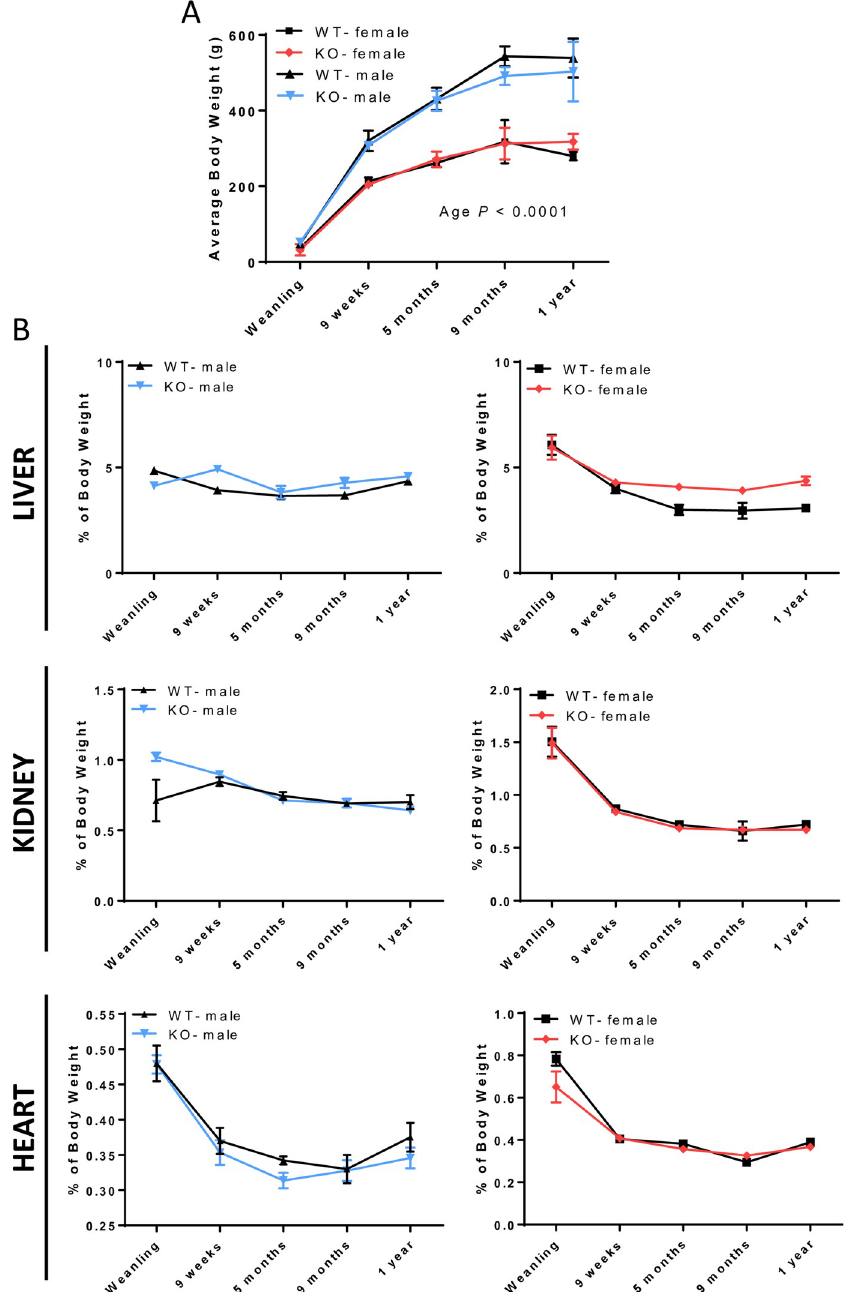
Fig 3. Hamp ablation did not alter growth rates or organ weights in male and female rats. Average body weights (recorded on the day of sacrifice) of male and female rats are depicted at several different ages ( A ). Data from males and females were analyzed separately but plotted together on the same graph. Organ weights as a percentage of body weight are shown in panel B . Data points are means ± SD for n = 8–14 rats/group and represent two independent trials at each age ( A, B ). Data were analyzed by 2-way ANOVA. No significant two-way interactions or main effects were noted (except for an Age main effect for body weight shown in panel A